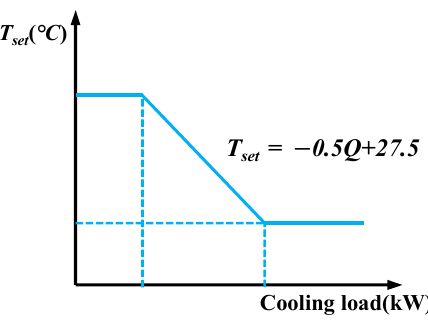
Figure 13. Load-based variable temperature set-point setting.